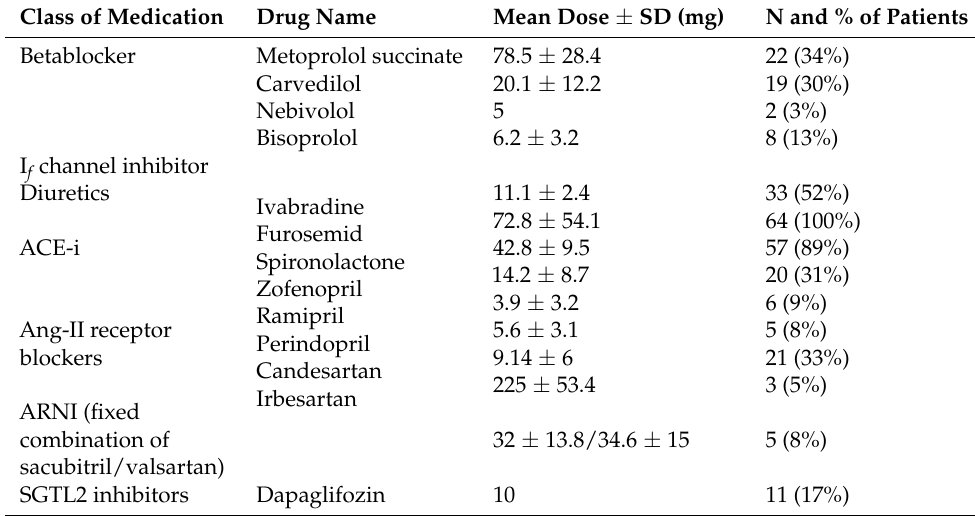
Table 2. Baseline medication—at the moment of pacemaker